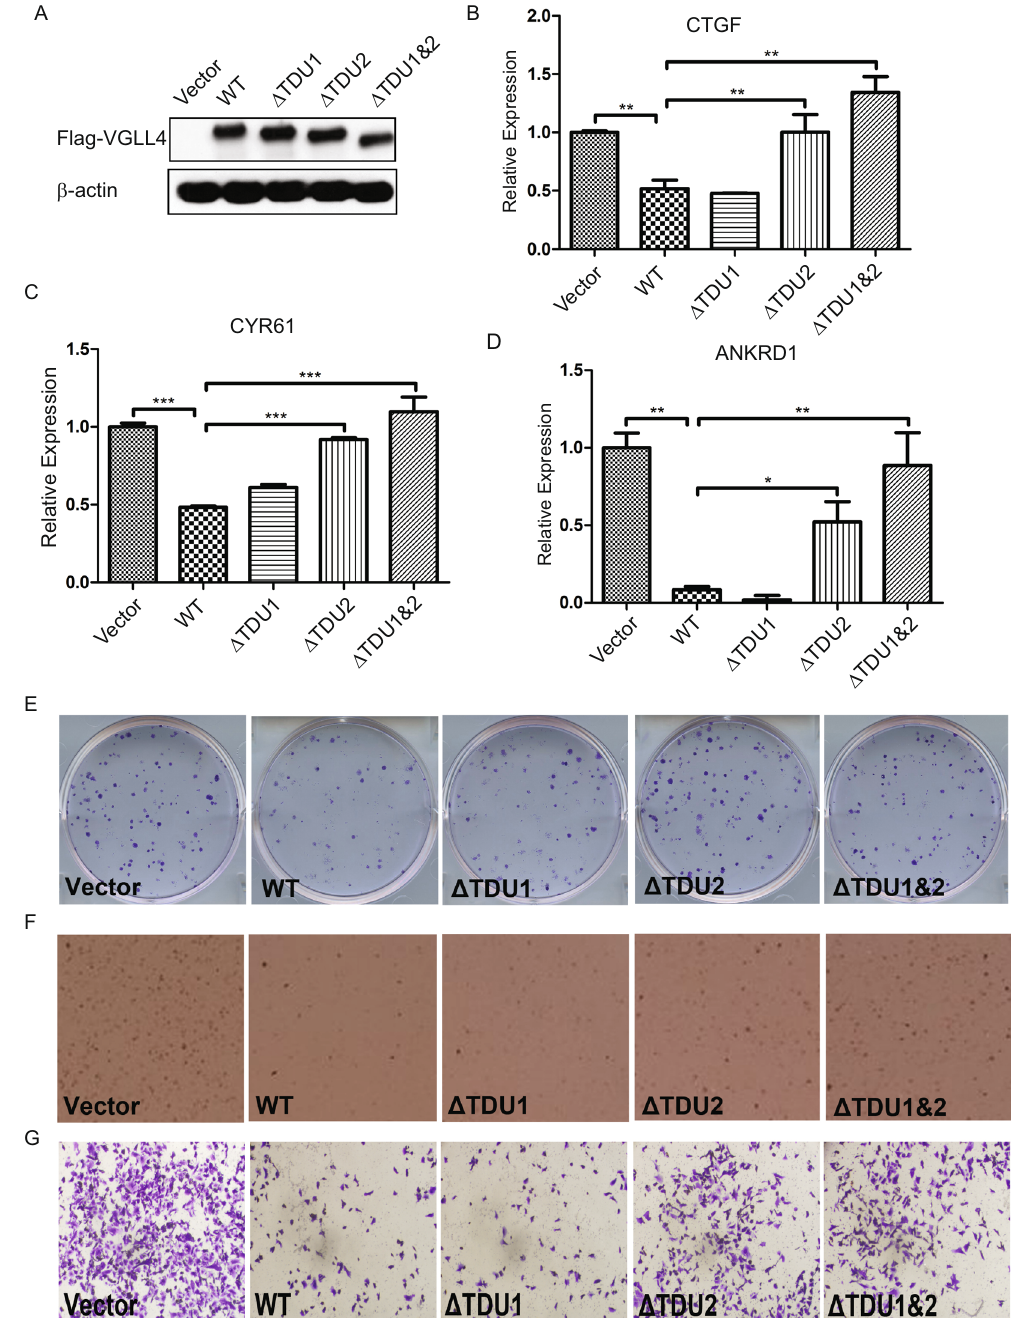
Figure 7. TDU2 domain deletion rescues the effect of VGLL4 suppression on cell proliferation and colony- formation in vitro . ( A ) Immunoblot of vector, WT or mutant VGLL4 expression in CAL-51 cells. Real-time qPCR measured expression levels of CTGF ( B ), CYR-61 ( C ) and ANKRD1 ( D ) for vector- or VGLL4- transduced CAL-51 cells. Representative images of colony-formation assay ( E ), anchorage-independent growth in soft agar ( F ) and cell migration ( G ) for vector, WT or mutant VGLL4 transduced CAL-51 cells. ( * P < 0.05, ** P < 0.01, *** P <